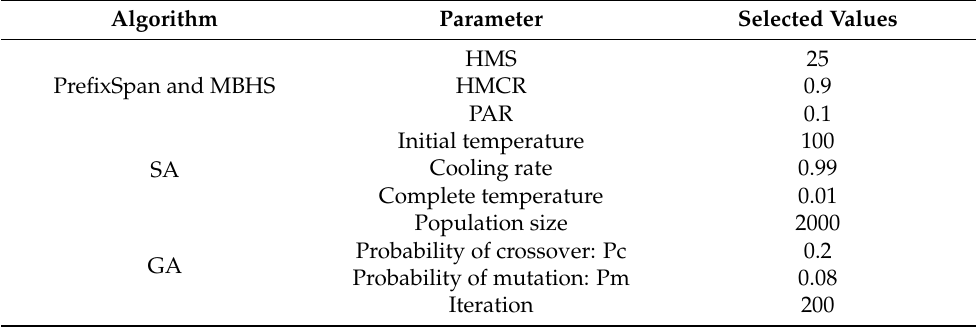
Table 14. The hyperparameters of the selected